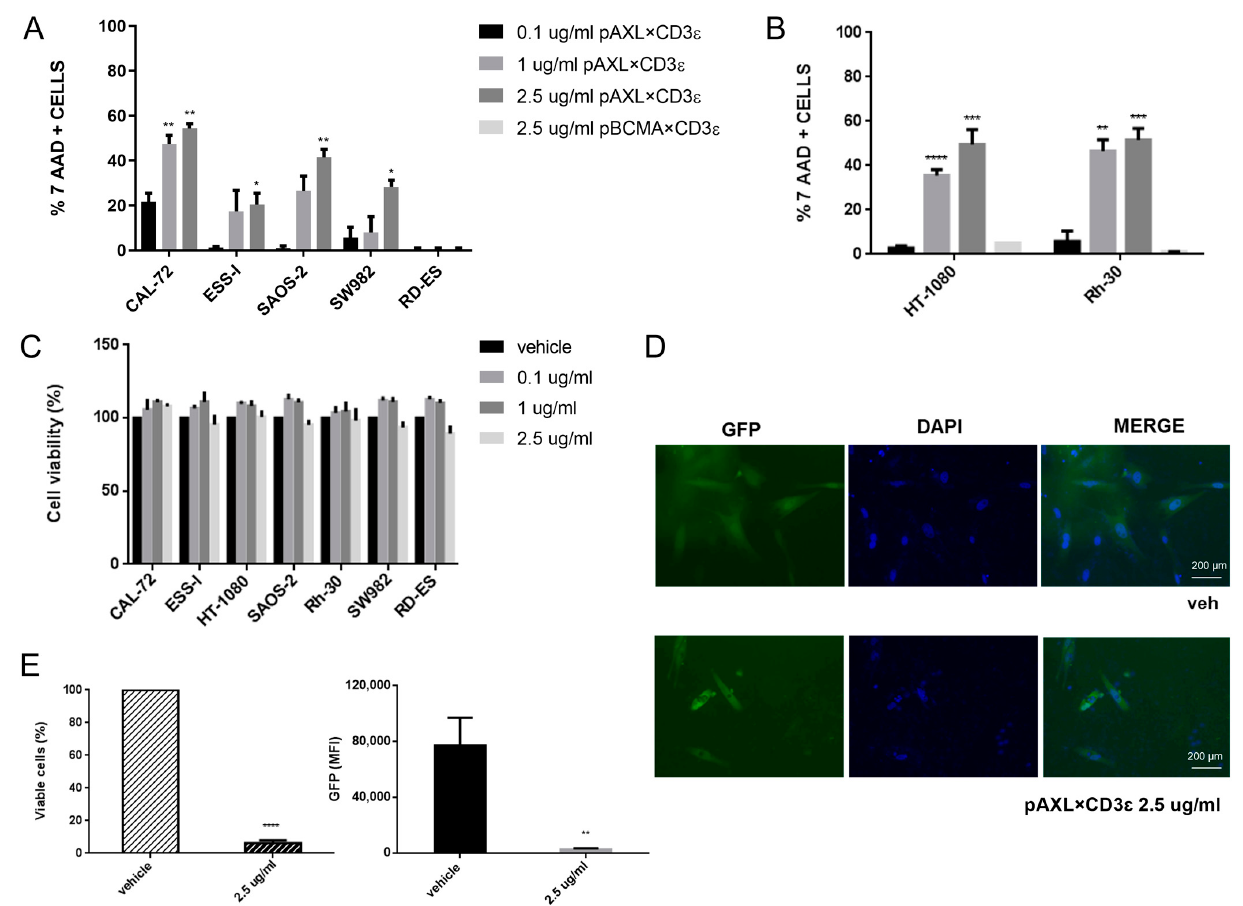
Figure 2. Redirected T-lymphocyte cytotoxicity by pAXL × CD3 ε in sarcoma cell lines. ( A ) FACS analysis of 7-AAD(7-amino-actinomycin D)-positive cells. ( B ) HT-1080 and Rh-30 treated with increasing concentrations of pAXL × CD3 ε (0.1 µ g/mL, 1 µ g/mL and 2.5 µ g/mL), and as a negative control 2.5 µ g/mL of pBCMA × CD3 ε after 72 h. Each group has been compared to the 0.1 µ g/mL group for statistical analysis. Results are normalized to the recorded vehicle values. ( C ) Cell Titer-Glo luminescent cell viability (%) assay performed on sarcoma cell lines without effector cells, following pAXL × CD3 ε 72 h treatment. ( C ) Positive cells (relative percentage %) of sarcoma cell lines co- cultured with peripheral blood mononuclear cells (PBMCs) and treated with different concentrations of pAXL × CD3 ε or vehicle for 72 h. Each group has been compared to the 0.1 µ g/mL group for statistical analysis. Results are normalized to the recorded vehicle values. ( D ) Imaging of CAL- 72 stably expressing green fluorescent protein (GFP) in untreated cells (vehicle) and 2.5 µ g/mL of pAXL × CD3 ε -treated cells after 72 h. Nuclei were stained with DAPI and microscopies were performed at 10-fold magnification. ( E ) Percentage of stably expressing CAL-72 GFP viable cells and median fluorescence intensity (MFI) of GFP analyzed by flow cytometry. PBMCs were obtained from 3 healthy donors and results are expressed as the mean value of triplicate experiments from each donor. * p < 0.0332; ** p < 0.0021; *** p < 0.0002; **** p <